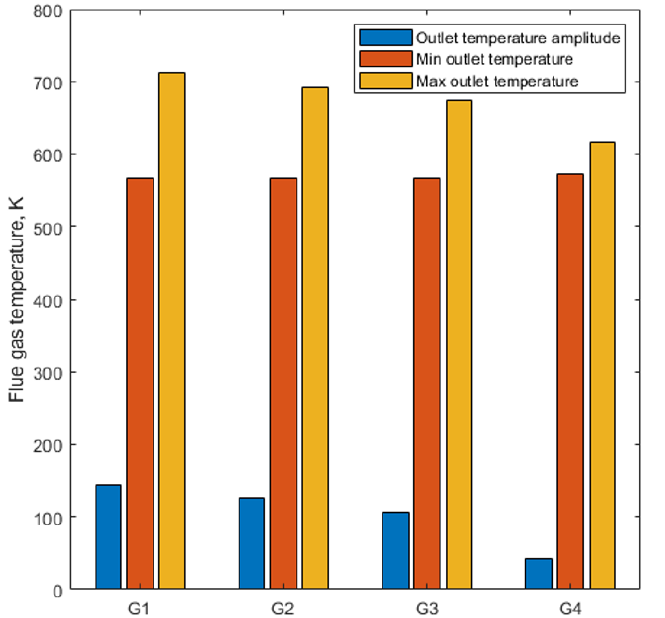
Figure 8. Plot of temperature and amplitude of flue gas temperature at duct outlet for each geomet- ric variant. ric